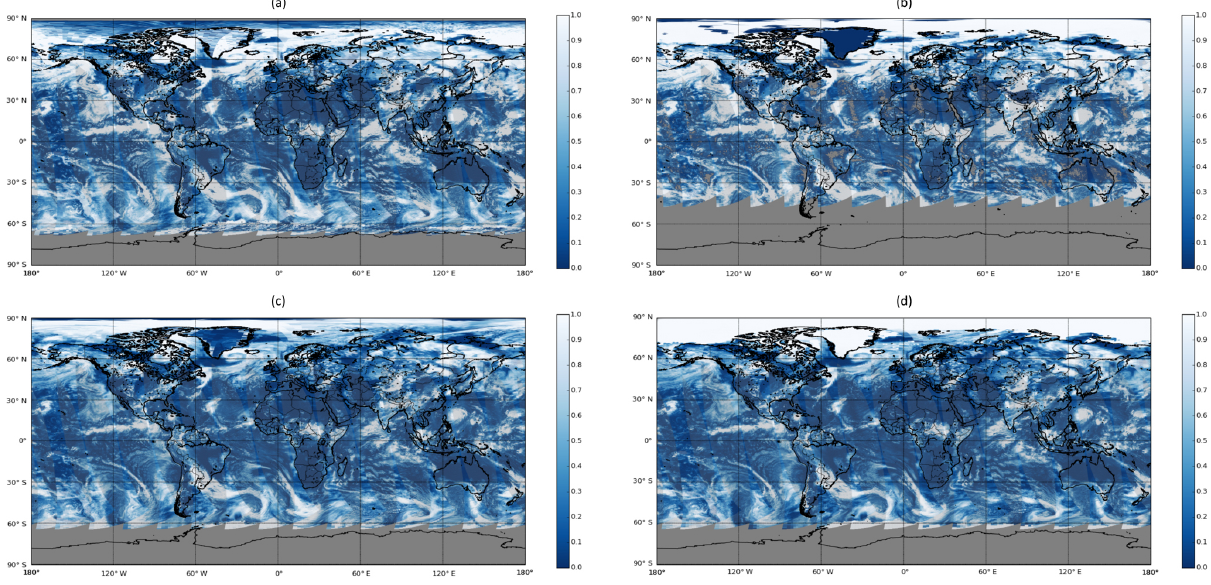
Figure 10. Cloud fraction retrieved with (a) OCRA, (b) OMAERUV, (c) OMCLDO2, and (d) OMCLDRR from OMI measurements on 16 July 2005.